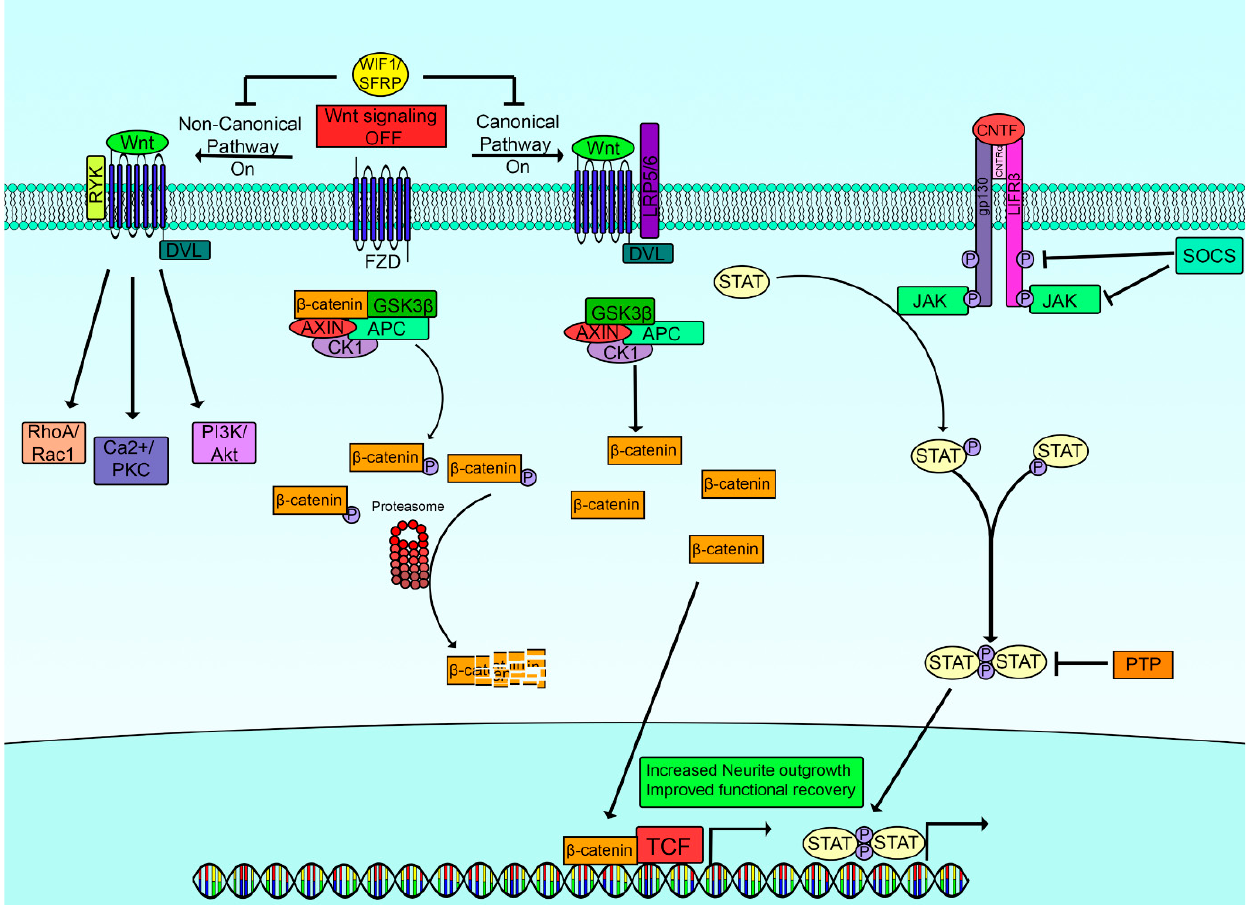
Figure 3. Overview and simplified schemata of major downstream activation pathways involving Wnt/ β -catenin and JAK/STAT with their convergence on transcriptional activation.